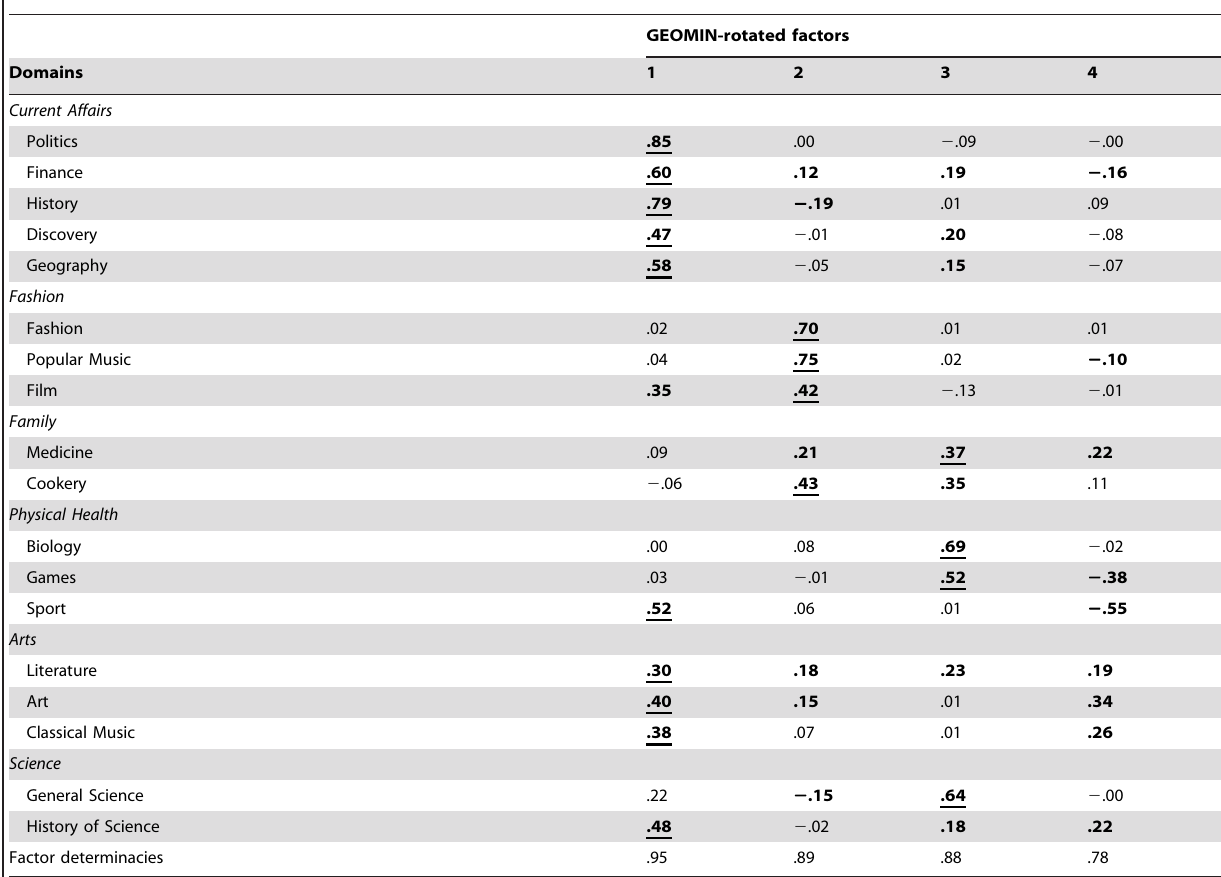
(Table 4). Factor 2 subsumed with highest loadings domains within Fashion and Cookery, and factor 3 Medicine, Biology, Games, and General Science. Factors 1 to 3 incorporated a larger number of cross-loadings, some of them also negative, whereas factor 4 appeared special as it contained exceptionally large negative cross-loadings of Games and Sport. Medicine, Literature, Art, Classical Music, and History of Science all had positive cross- loadings on this factor. Moreover, factors 1 to 3 were positively inter-correlated (factor 1 with factor 2: r = .65, p , .001; factor 1 with factor 3: r =.40, p , .001; factor 2 with factor 3: r = .19, p , Table 4. Loadings in the 4-Factor